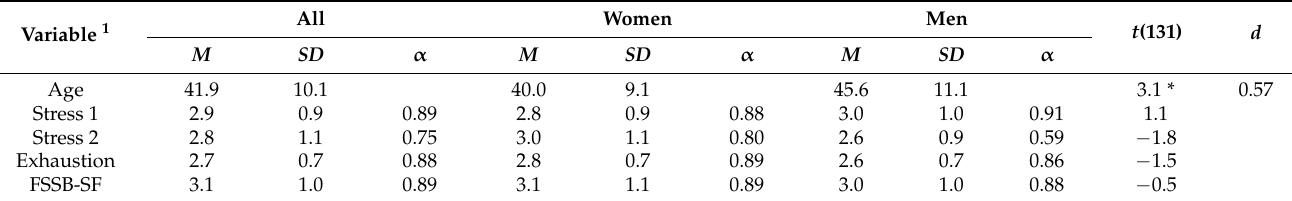
Table 2. Descriptive